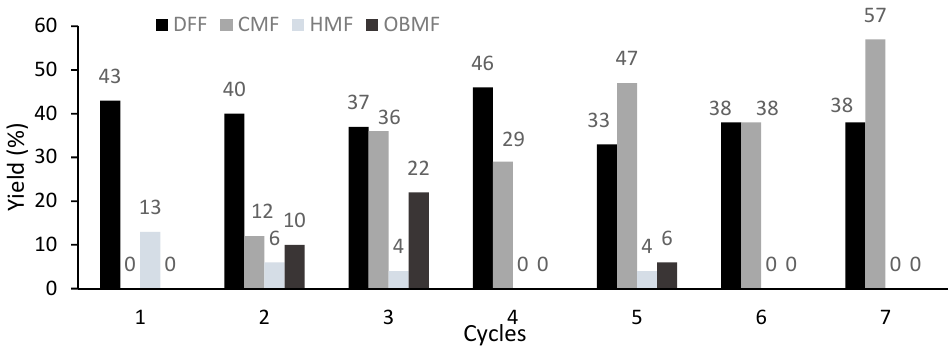
Figure 6. Catalyst reuse for the oxidation of CMF. Reaction conditions for each cycle : CMF (0.35 mmol, 50 mg), 0.5 equiv. of CuSO 4 ·Si 10%, 4 equiv. of PNO in TGDE (0.5 M) at 160 °C for 5 min under microwave irradiation; yields were determined by 1 H-NMR analysis of the crude reaction mixture using 1,3,5-trimethoxybenzene as an internal standard. OBMF: 5,5 ′ -oxybis(5-methylene-2-furaldehyde).